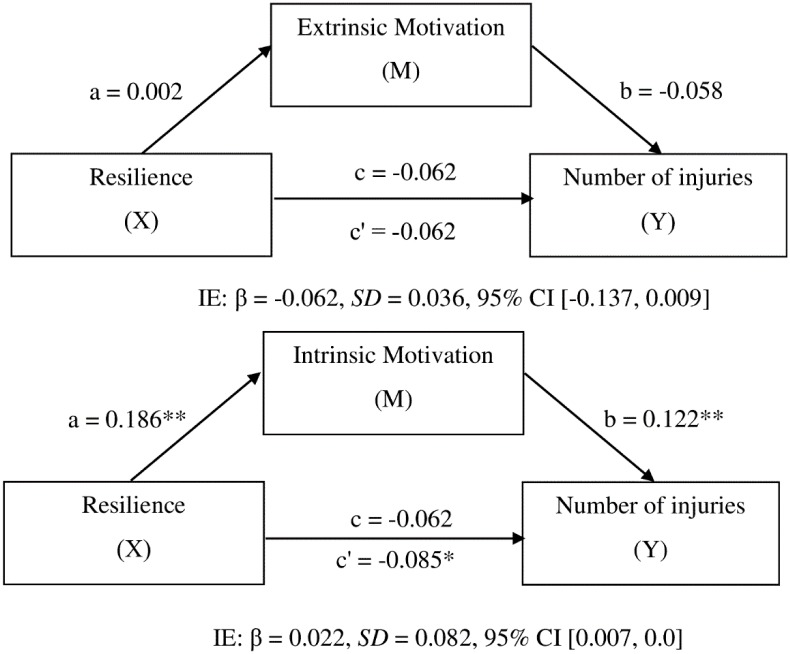
Mediation model.